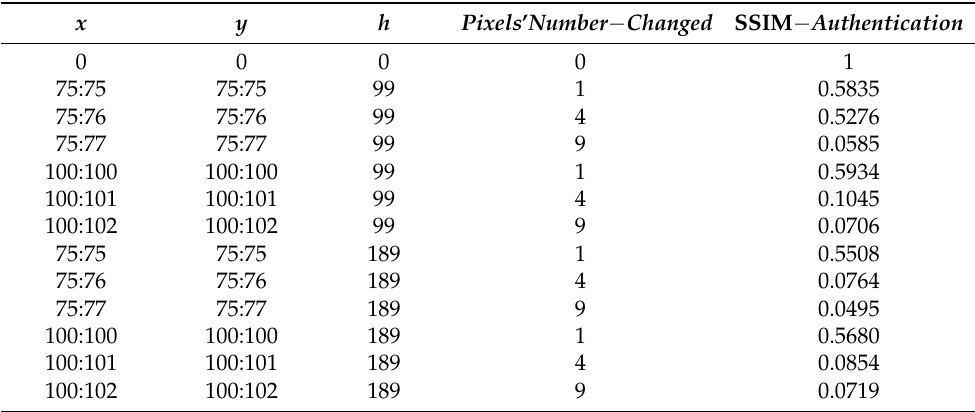
Table 3. The results with different numbers of pixels changed.